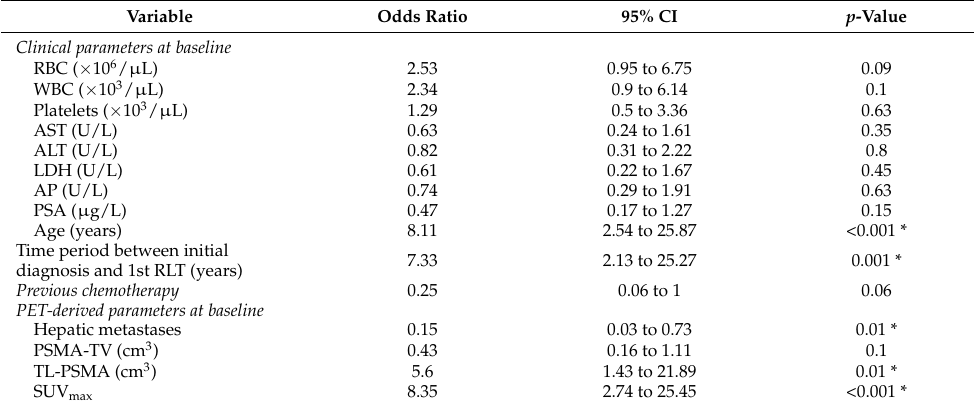
Table 2. Univariate predictors for early biochemical